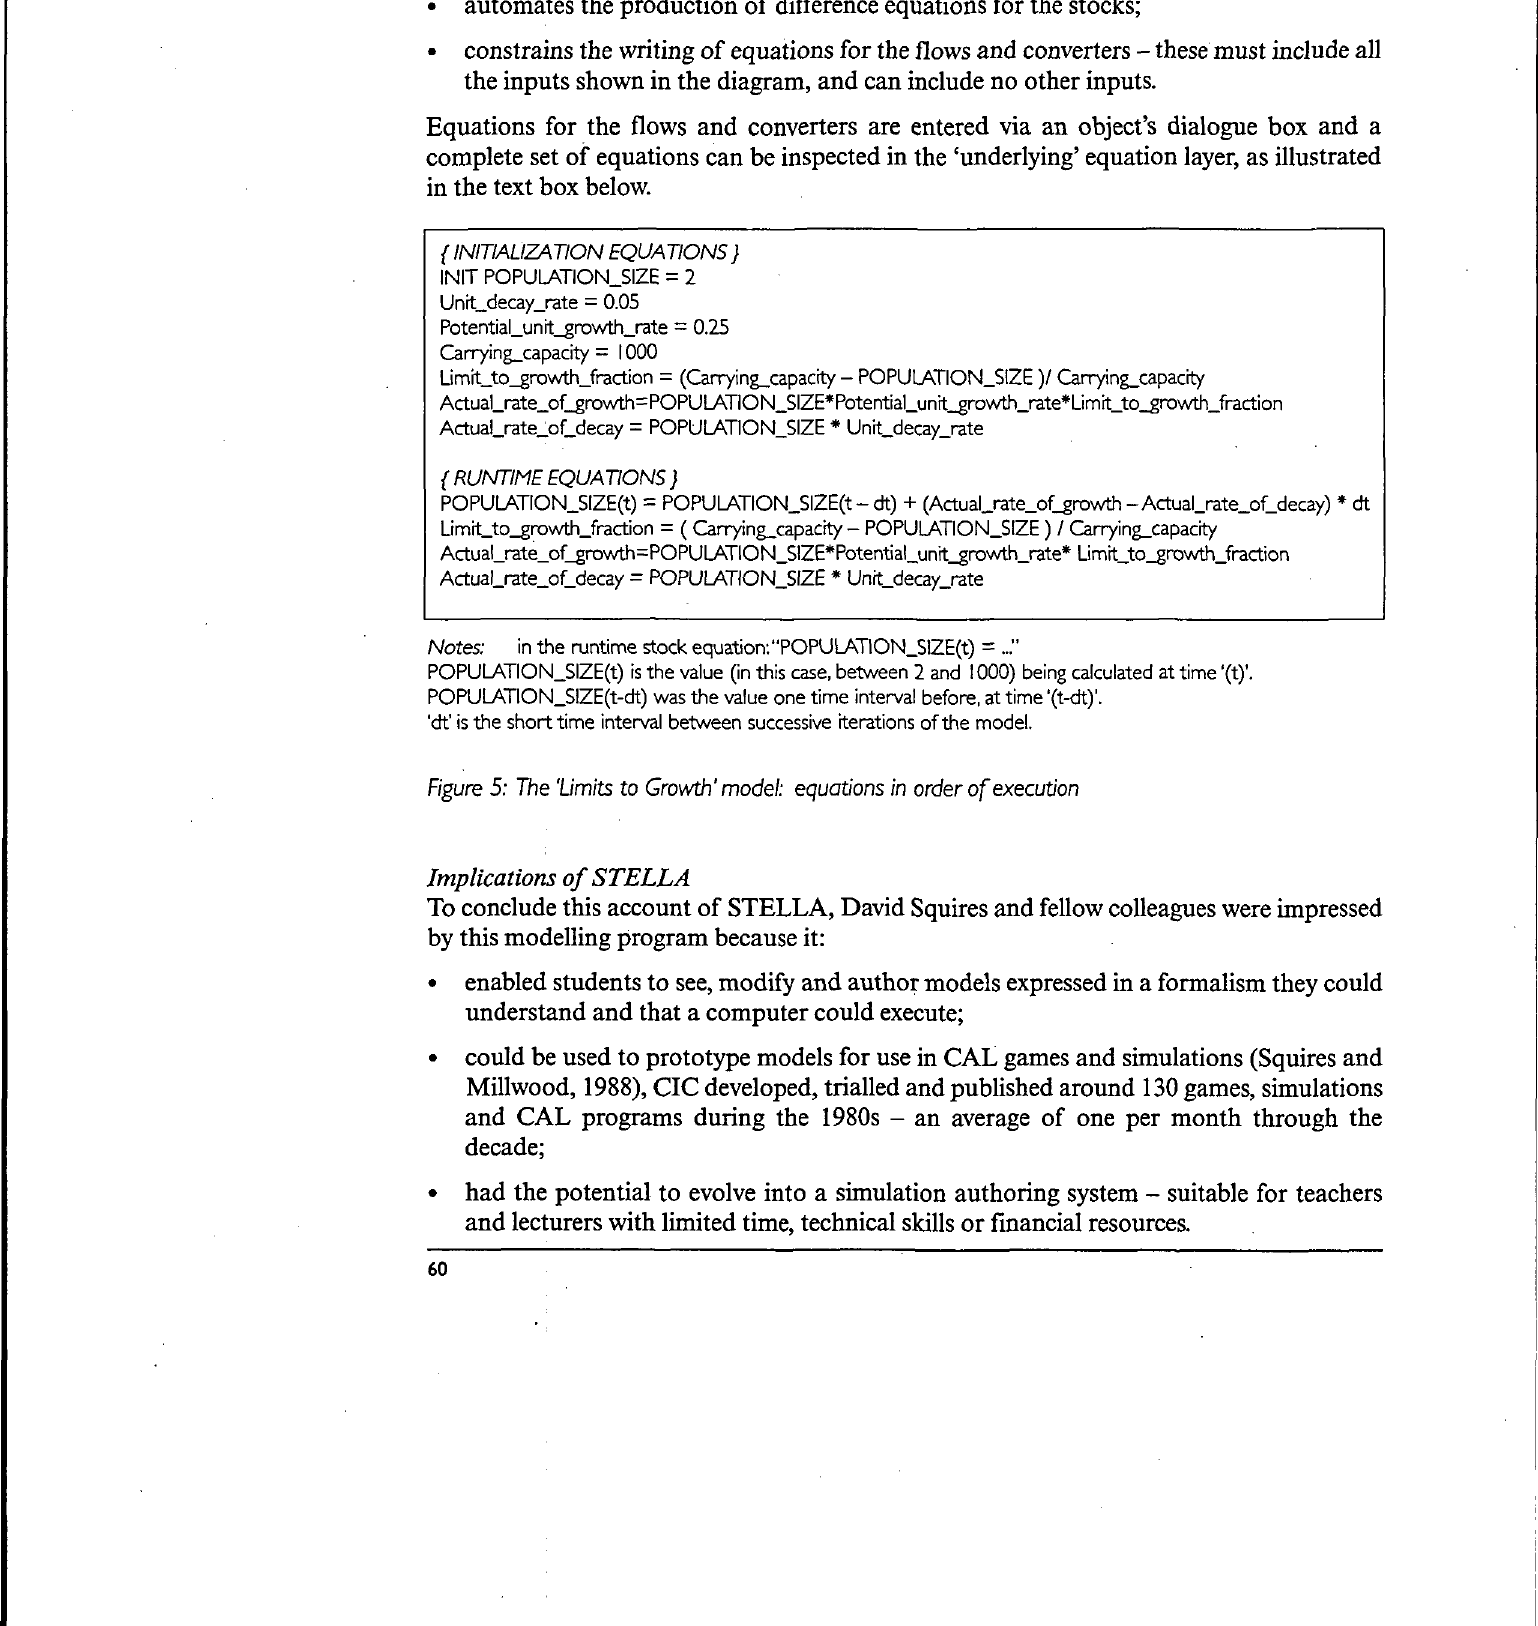
Figure 5: The 'Limits to Growth'model: equations in order of execution